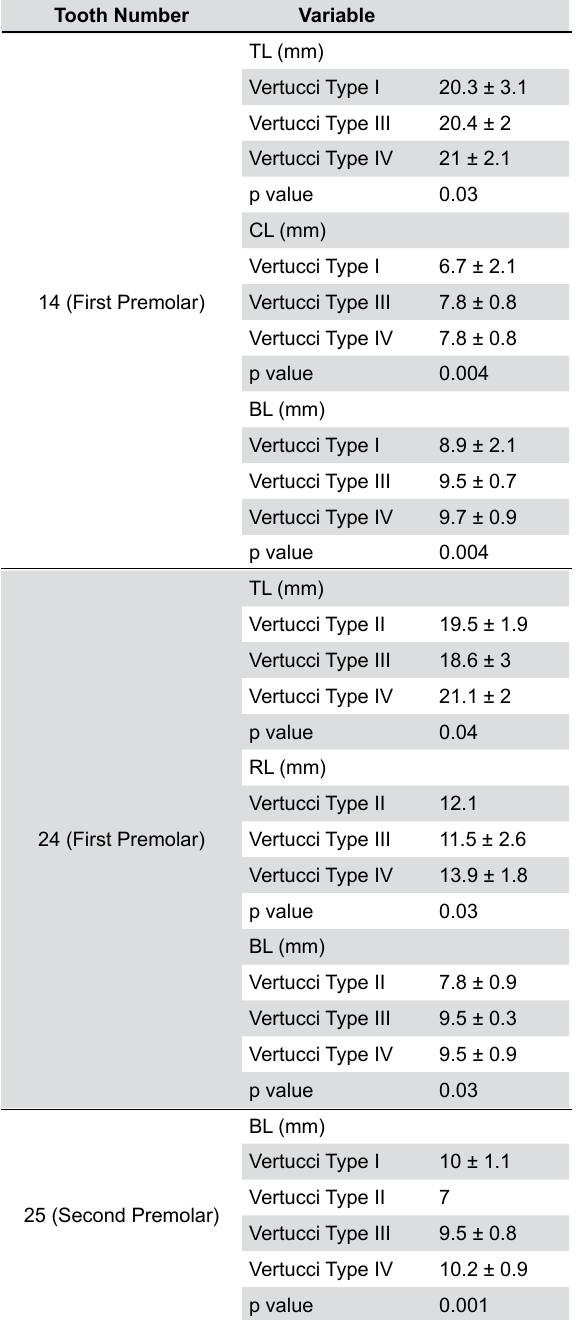
Table 3- Statistically significant relations between tooth anatomic sizes and Vertucci’s Root Canal system (maxillary